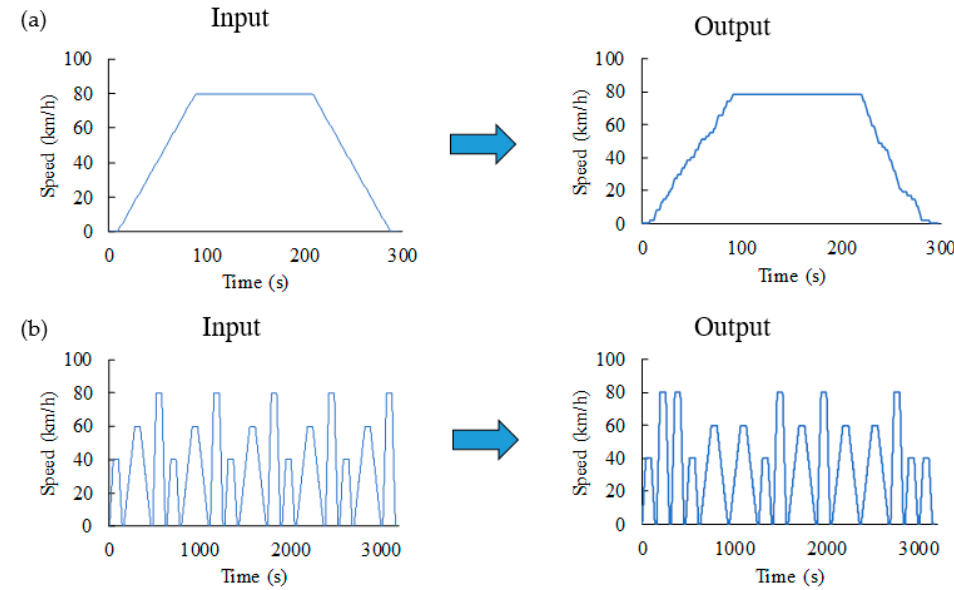
Figure 3. Illustration of the test used to verify the correct implementation of the methods to construct DCs. Artificial trips used (left side) and DCs (right side) obtained by ( a ) the MCMC and MT ( b ) the MT methods.